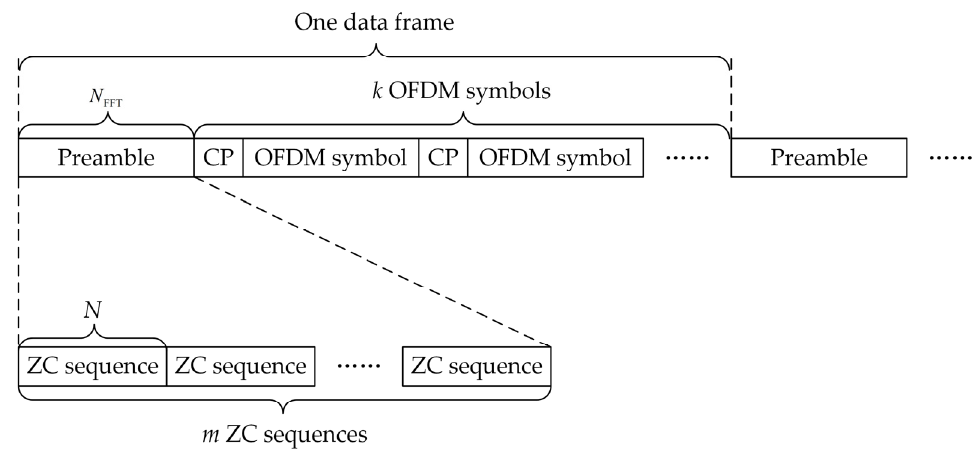
Figure 2. The structure of the new preamble based on the ZC sequences.